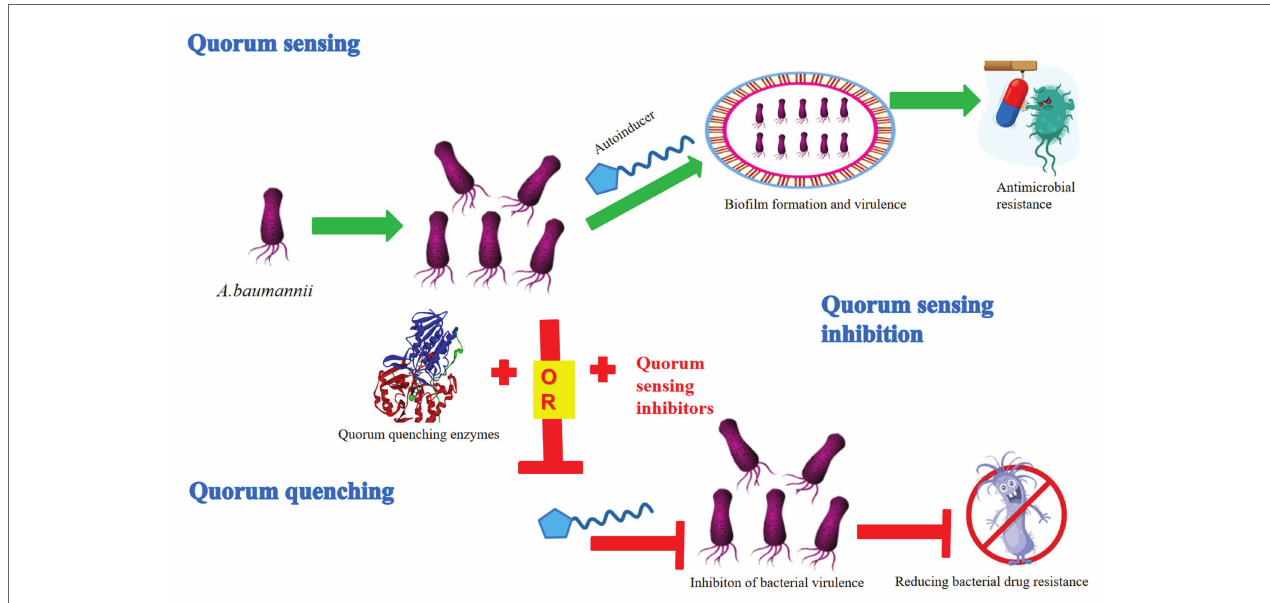
FIGURE 1 | Mechanism diagram of quorum sensing inhibition or quenching through the QS system in A. baumannii . The QS system participates in the formation of biofilm and virulence of A. baumannii via various autoinducers, thus resulting in antimicrobial resistance. In contrast, the two main mechanisms of QS interference, quorum sensing inhibition and quorum quenching, have been developed to inhibit the virulence of bacteria, thus reducing the pressure to produce bacterial drug